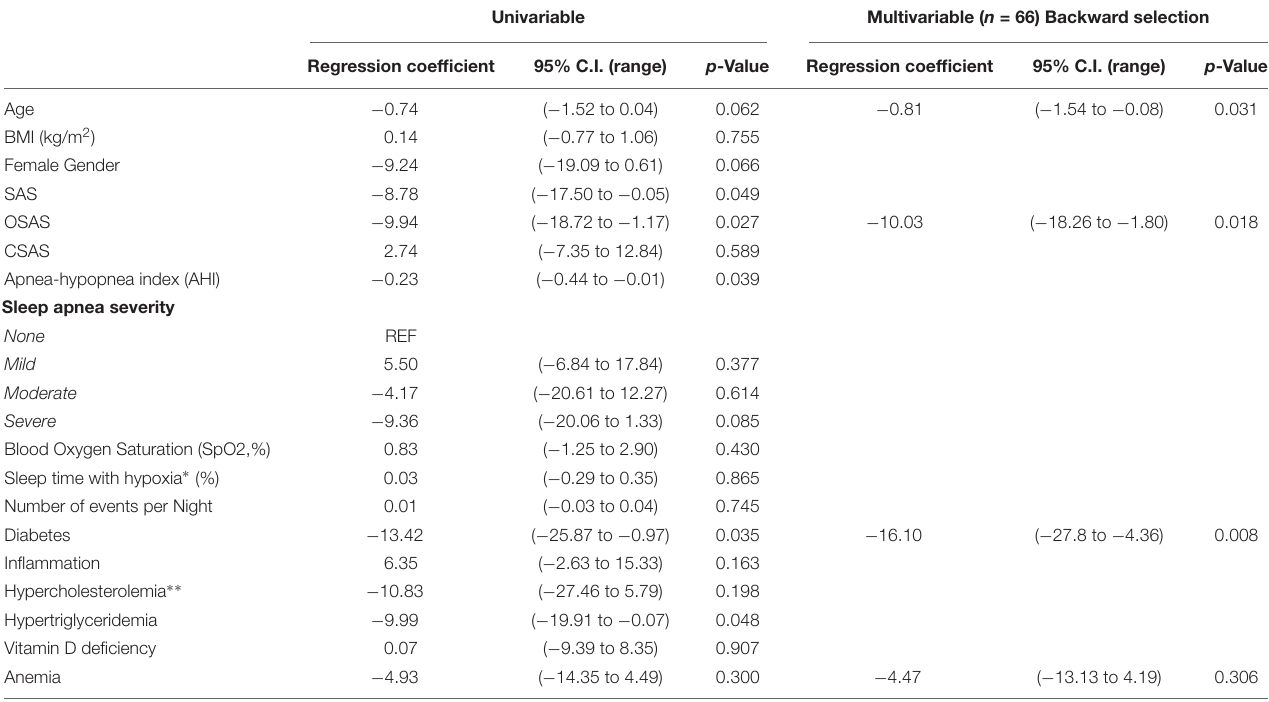
TABLE 5 | Uni- and Multi-variable regression to identify factors associated with the Mattis Dementia Rating Scale (MDRS). Univariable